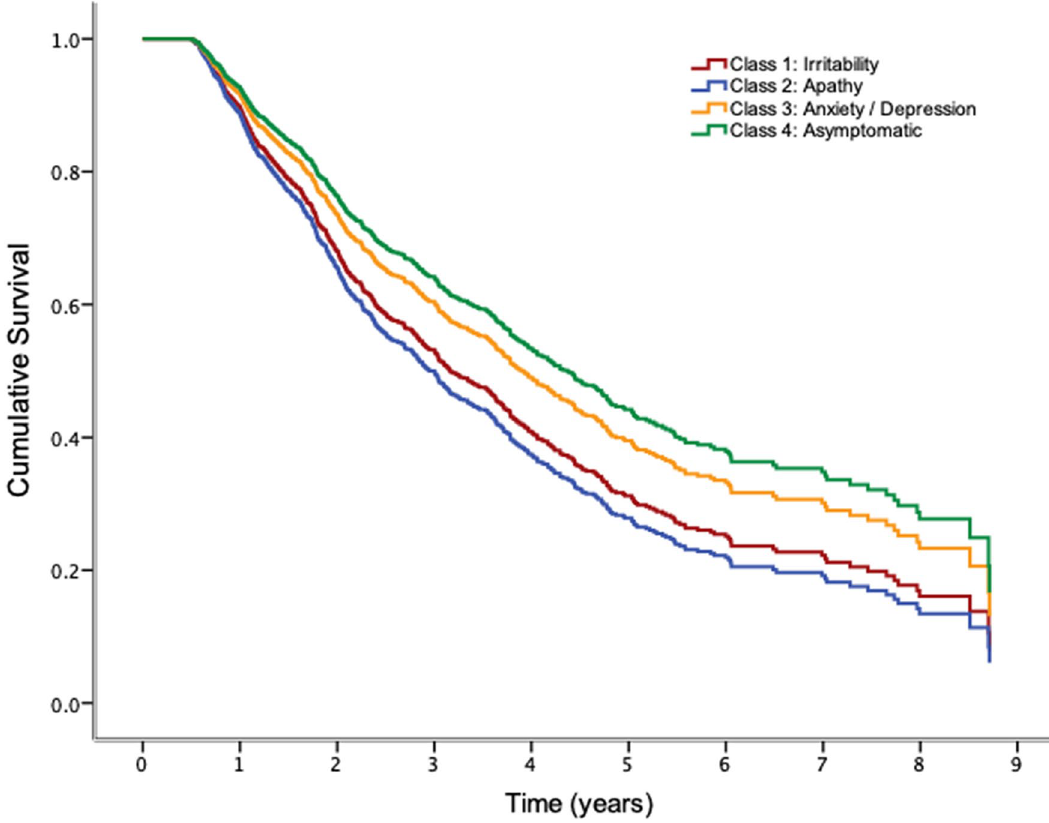
Figure 2. Survival curves of model 2 (adjusted by age, gender, mini-mental state examination and years of education) of the 4-class model obtained with LCA. Irritability and apathy classes showed significant increased hazard risks to convert to dementia compared to asymptomatic class. AD BvFTD